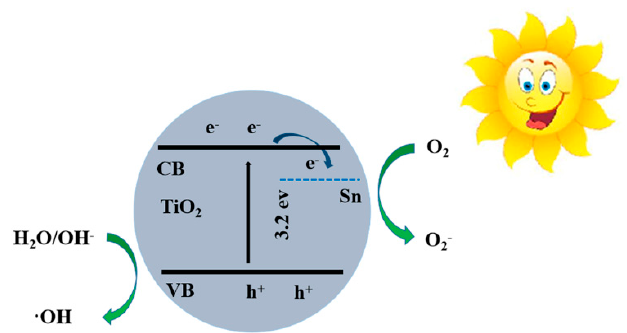
Figure 12. The energy band and photoinduced charge separation and transport in STO hierarchical nanospheres. CB, conduction band; VB, valence band. nanospheres. CB, conduction band; VB, valence band.